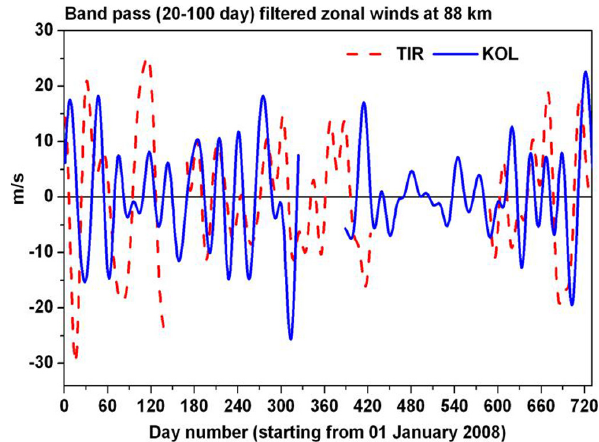
Fig. 3. Band pass (20–100 days) filtered daily zonal winds at 88km observed at Kolhapur (KOL) and Tirunelveli (TIR) for the observa- tional period 1 January 2008–31 December